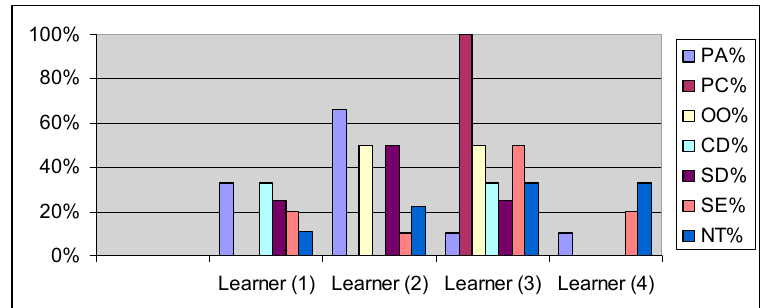
Figure 24. Learners’ participation ratio for Group 3.